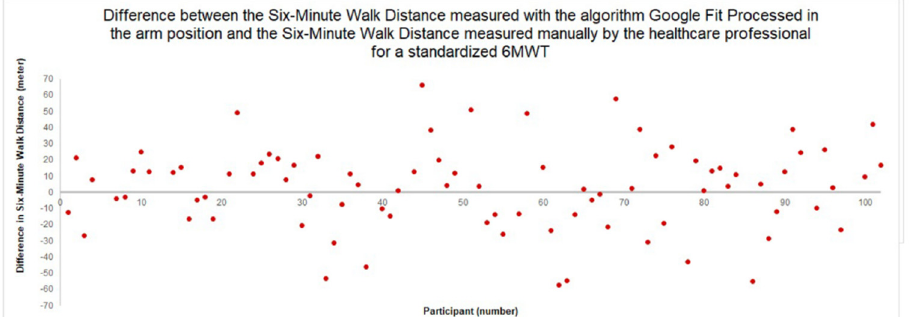
Figure 3. Bland–Altman plot of the difference between the 6MWD for the standardized 6MWT as measured by the algorithm Google Fit Processed in the arm position, and as measured by the healthcare professional.